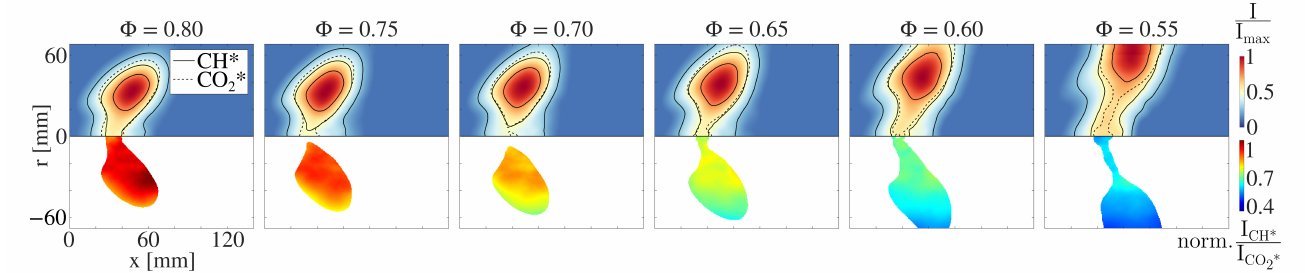
Figure 10. ( Upper half: ) Locally resolved CH* chemiluminescence intensity for kerosene combustion at an air mass flow rate of ˙m air =25g/s. The solid black lines represent the 75%, 50% and 25% isolines of the chemiluminescence intensity. The dashed black line represents the 50% isoline of the corresponding CO 2 * chemiluminescence intensity. ( Lower half: ) Locally resolved CH*/CO 2 * distribution. The values are normalized to the mean CH*/CO 2 * ratio at Φ